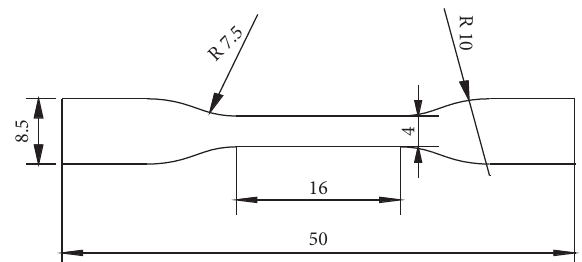
Figure 1: Dimension of the quasistatic tensile specimen.